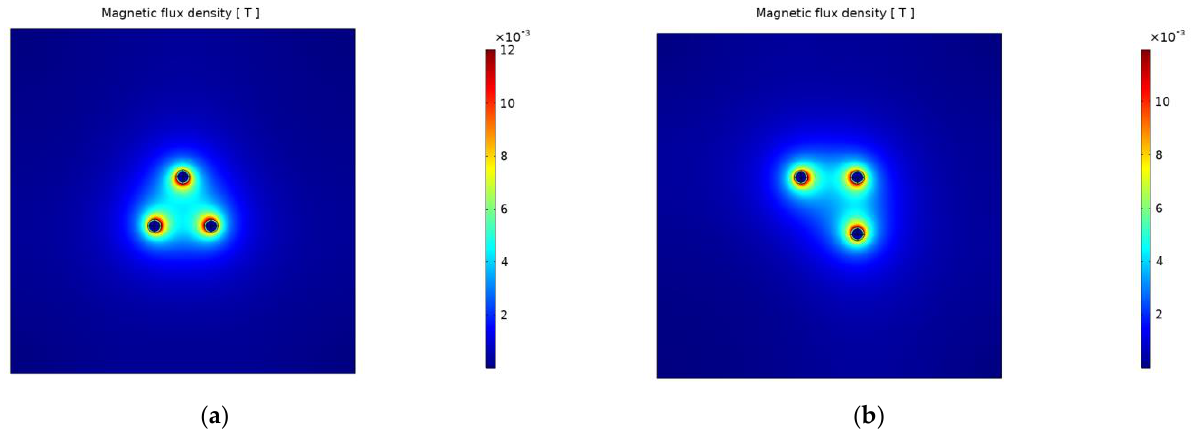
Figure 11. Magnetic flux density for at 60 Hz for: ( a ) Model 5; ( b ) Model 6.